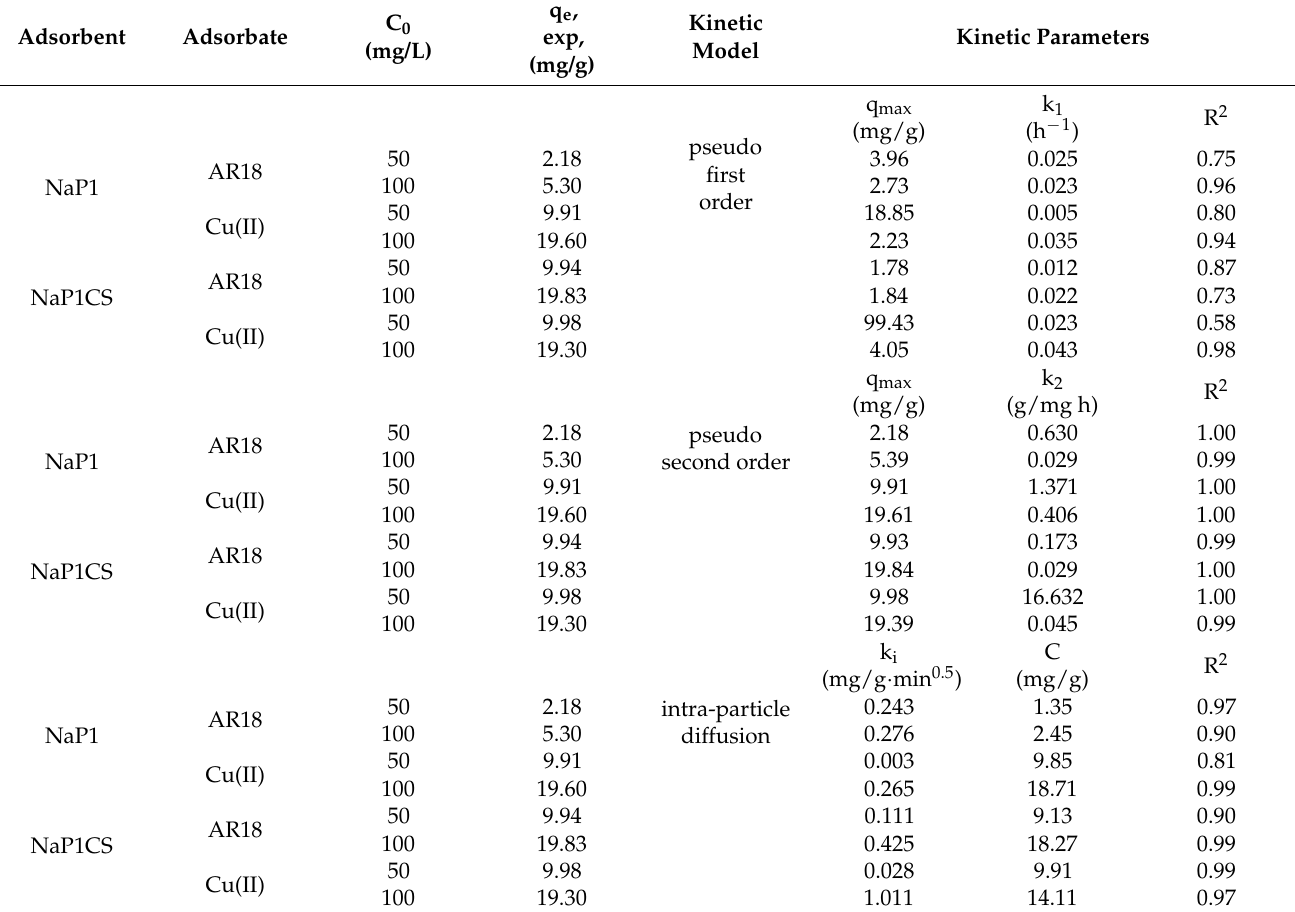
Table 3. Kinetic parameters for the adsorption of AR18 and Cu(II) on NaP1 and NaP1CS.